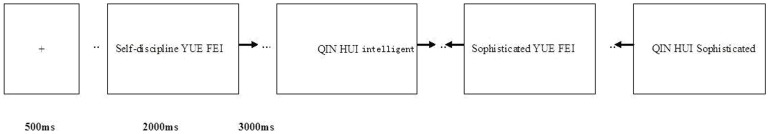
Positive approach - negative avoidance (consistent pattern).The Group 1 condition tested a consistent pattern based on visual words. A reference name appeared on the center of the screen, and a corresponding personality adjective appeared on either the left or the right side of the reference name.